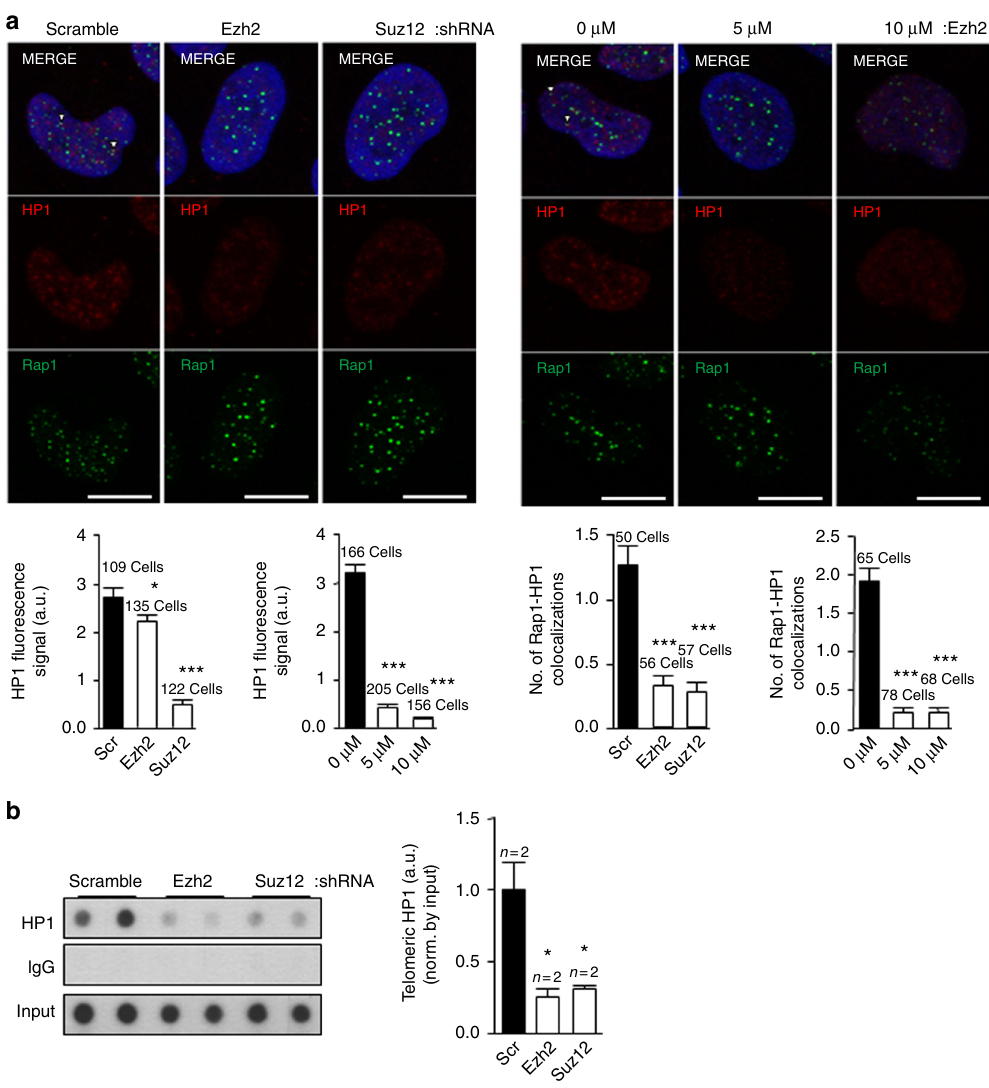
Fig. 6 Global HP1 and its localization at telomeres depend on PRC2 levels. a Representative images of the average number of colocalizations of RAP1 (green) and HP1 (red) in the U2OS infected with scramble, EZH2, or SUZ12 shRNA (left panel) or in U2OS treated with vehicle or with EZH2 inhibitor. Arrowheads indicate colocalization events. Scale bar, 10 μ m. Quanti fi cation of (left graphs) total HP1 and (right graphs) the colocalization between RAP1 and HP1 (mean values± s.e.m., n = number of cells). b Telomeric ChIP-dot-blot of the HP1 protein for the U2OS cells infected with scramble, EZH2, or SUZ12 shRNA. IgG was used as a control. DNA input signal is also shown. Quanti fi cation of the immunoprecipitated telomeric repeats normalized by the input is shown below (mean values ± s.e.m., n = technical replicates). Student ’ s t -test was used for the statistical analysis (* p < 0.05, ** p < 0.01, and *** p <